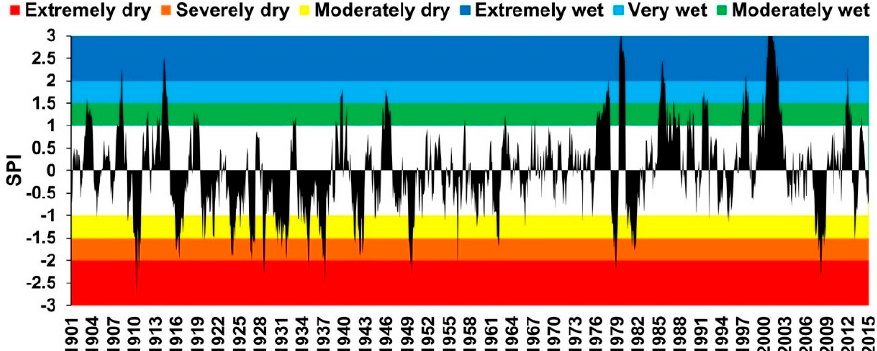
Figure 3. Twelve-month SPI for the Santa Catalina stream basin from 1901 to 2015. Table 1. Characterization of water extremes at the Santa Catalina stream basin through the use of the 12-month SPI.